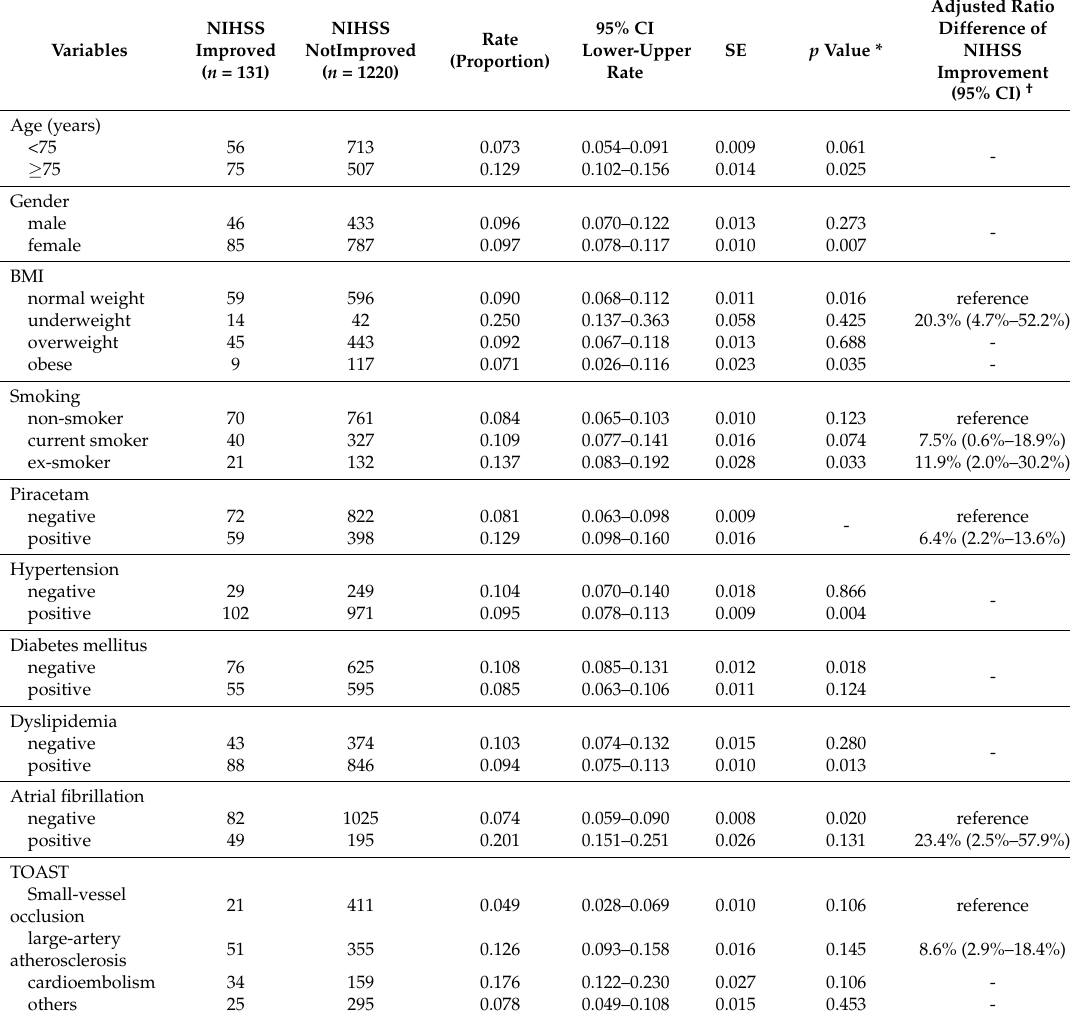
Table 3. Subgroup analysis of clinical variables for the associations of piracetam with NIHSS score improvement and the adjusted ratio difference in each clinical category in Taiwan ischemic stroke